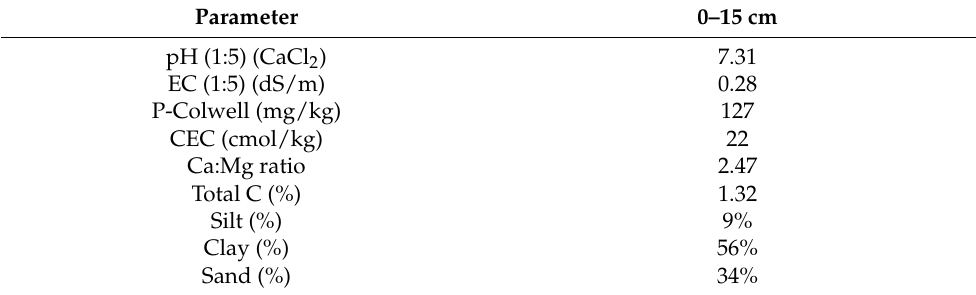
Table 1. Initial physical and chemical properties of the experiment soil.